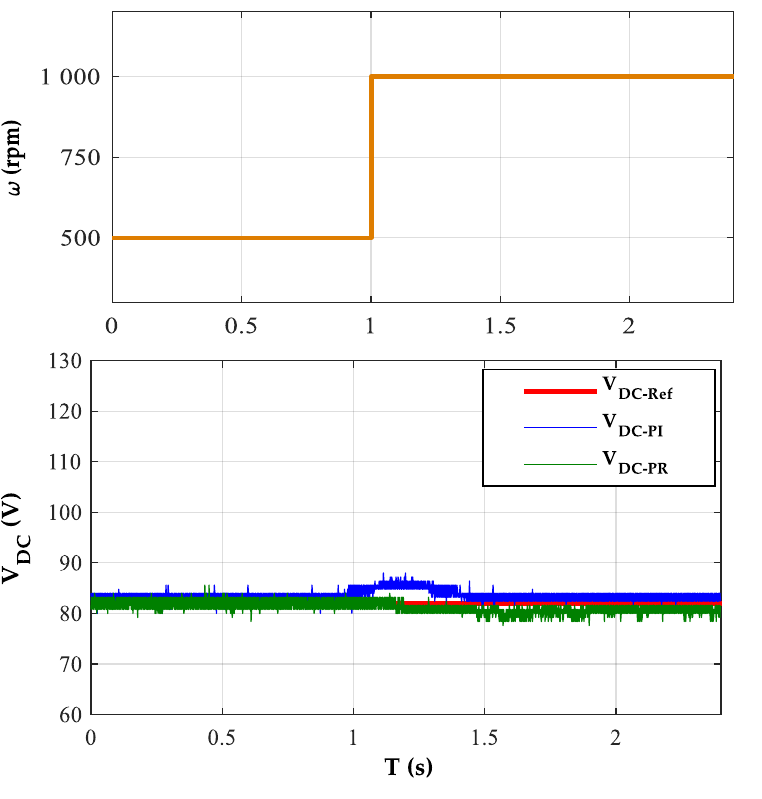
Figure 14. The experimental results of two methods controlling the SRG power generation system from 500 rpm to 1000